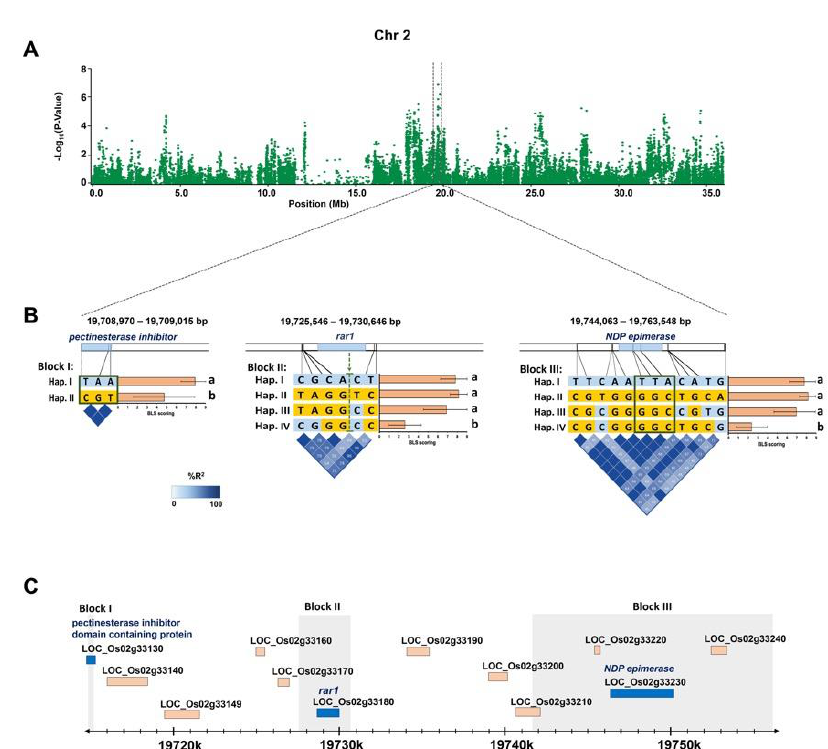
Figure 6. Identification of the candidate gene for the peak of qBLS2.3 on chromosome 2. ( A ) Manhattan plot on chromosome 2 based on mixed-linear Model (MLM). The peak region is indicated in the block between two vertical dotted lines. ( B ) Haplotype blocks (upper) and LD structures (lower) of the associated SNPs. SNPs located in the genes are highlighted in the box. The bar graph shows the average BLS scores of rice accessions corresponding to each haplotype group. Letters to the right most of the bar graph indicate significant groups. BLS disease scoring ranges from 0–9 (0 = resistance, 9 = susceptible). Color codes for nucleotides in the haplotypes: yellow represents minor alleles and blue represents major alleles. ( C ) Annotated genes within the LD block region of qBLS2.3. The candidate gene in each LD block is highlighted in blue.